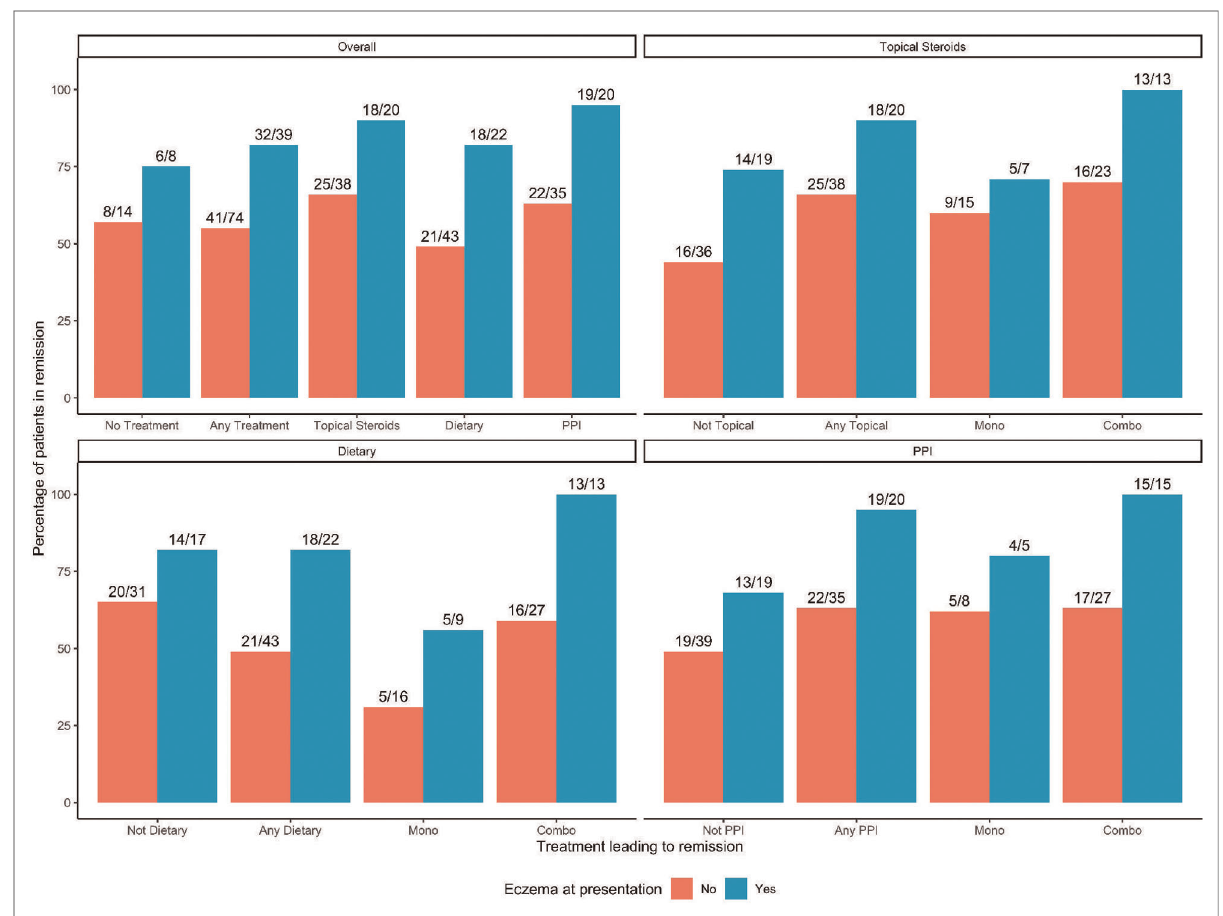
FIGURE 3 Eczema status and remission rate by treatment group. Bar graphs of history of eczema at presentation and therapies by remission rate. Overall includes any therapy and no